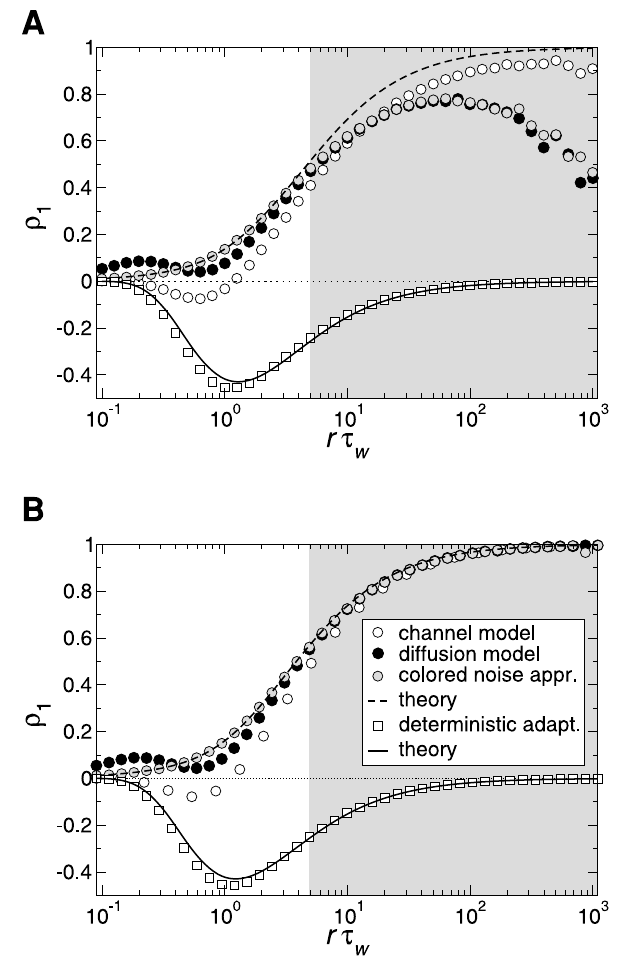
Figure 9. Serial correlation coefficient at lag 1 as a function of the time scale separation. A Serial correlation coefficient r 1 in the case of N a ~ 200 channels (corresponding to ~ 0 : 1 ) for stochastic (cid:3) ms for deterministic adaptation (circles, Eq. (3)) and D ~ 0 : 01 V 2 th adaptation (squares, Eq. (2)). Theoretical curves for stochastic adapta- tion, Eq. (72), and deterministic adaptation, Eq. (9), are displayed by a dashed line and a solid line, respectively. The zero baseline is indicated by a dotted line. B shows the corresponding plot for N a ~ 500 channels (cid:3) ms . The gray-shaded (corresponding to ~ 0 : 04 ) and D ~ 0 : 004 V 2 th region marks the relevant range for spike-frequency adaptation. r t w was varied by changing t w at fixed m ~ 0 : 4 ( S T i T ~ 10ms ), all other parameters as in Fig.